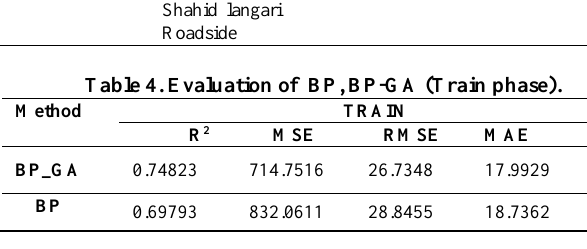
Figure 4. Distribution of test data in the BP-GA.